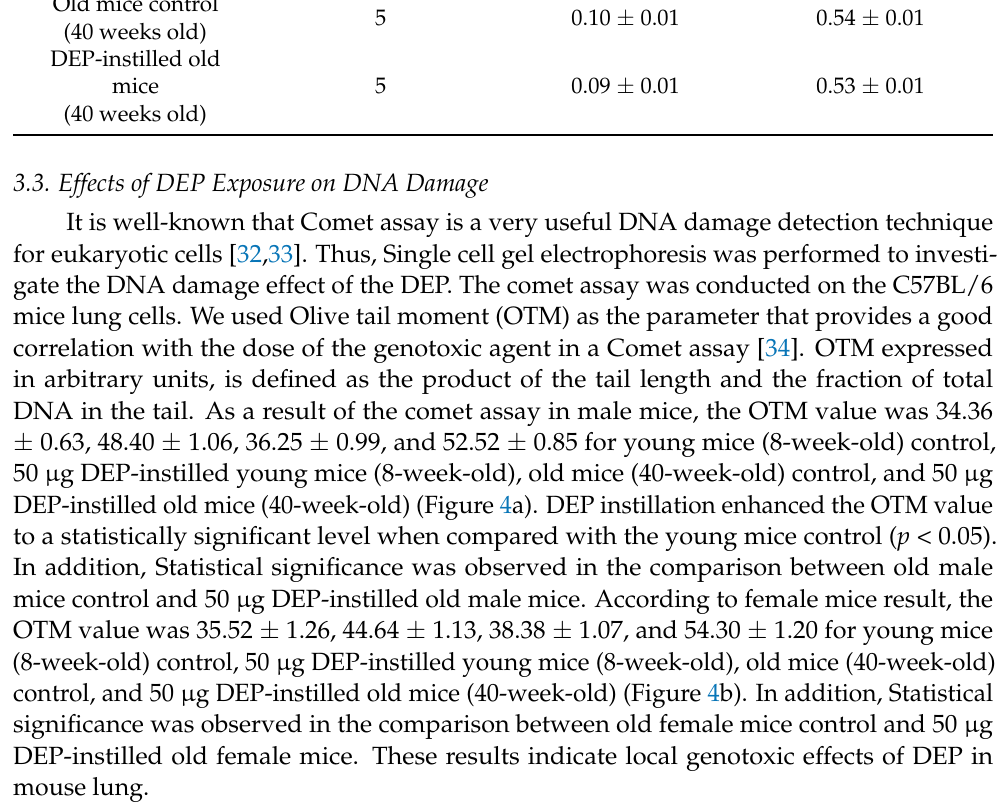
The Frequency of Micronuclei (%, Mean ±